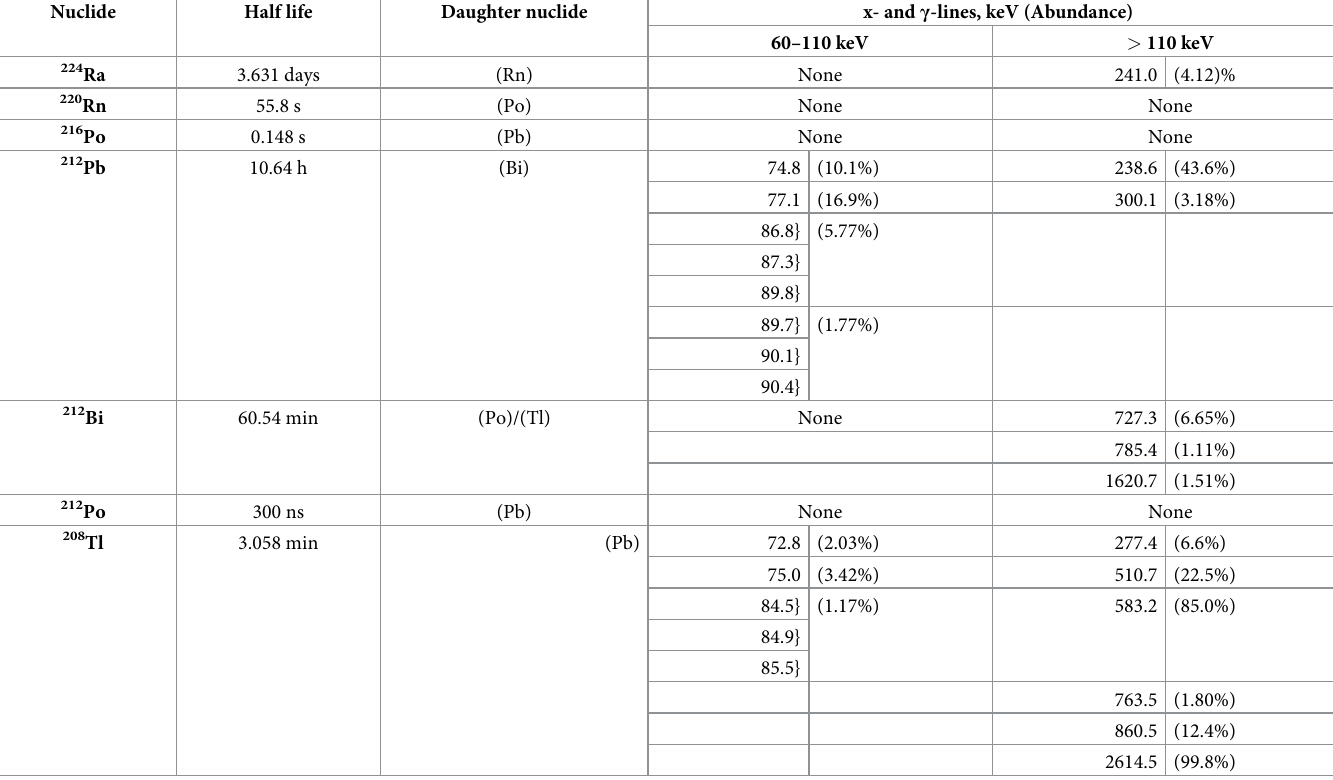
Table 1. Details of the nuclear decay data for 224 Ra and its daughters indicating x- and γ -lines with 1% or higher abundance and divided into two columns: one for energies in the 60–110 keV detection window and the second for energies above 110 keV. Nuclide Half life Daughter nuclide x- and γ -lines, keV (Abundance) 60–110 keV > 110 keV 224 Ra 3.631